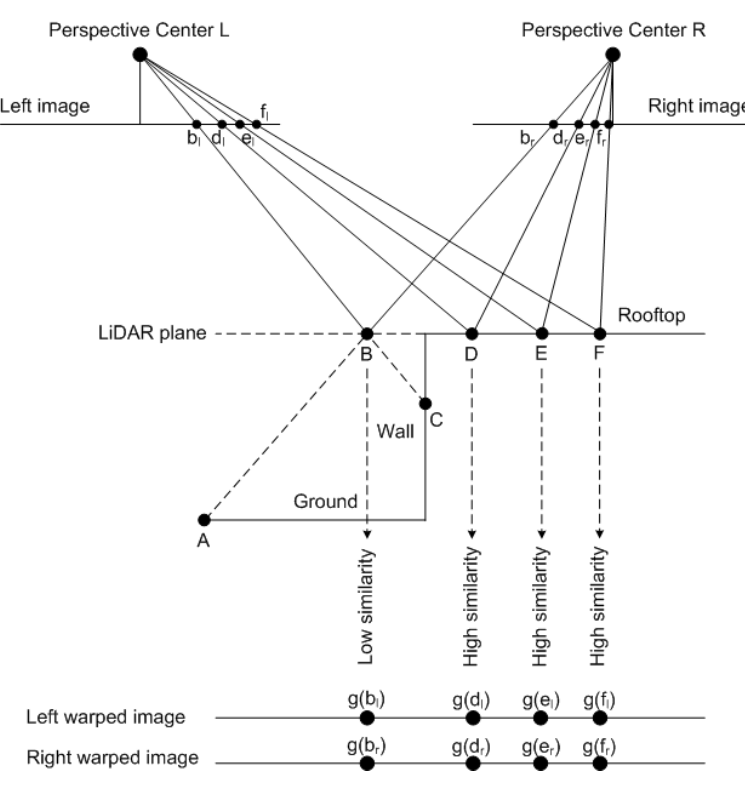
Figure 4. Concept of warped